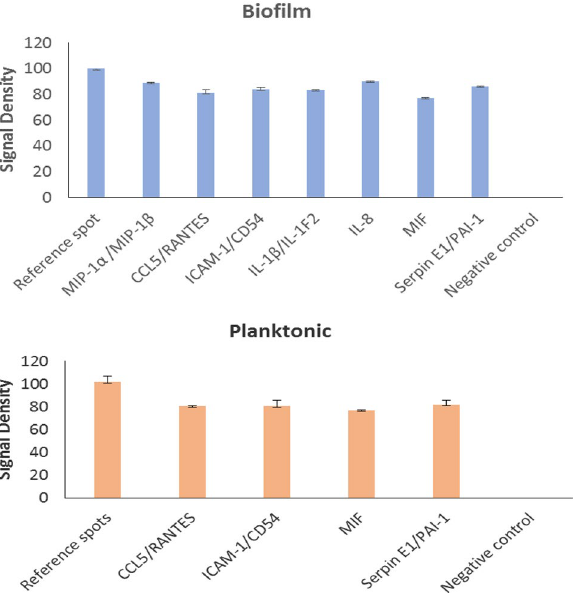
Figure 5. Cytokine induction from human whole blood by P. intermedia biofilm and planktonic cells. Human whole blood collected from a healthy volunteer was stimulated by secretome preparations from the biofilms and planktonic cultures of P. intermedia for 24 h. The cytokines produced were detected by using Proteome Profiler™ membrane array. Means (SD) of signal densities of spots were determined using Gene Tools analysis software in Syngene Imaging